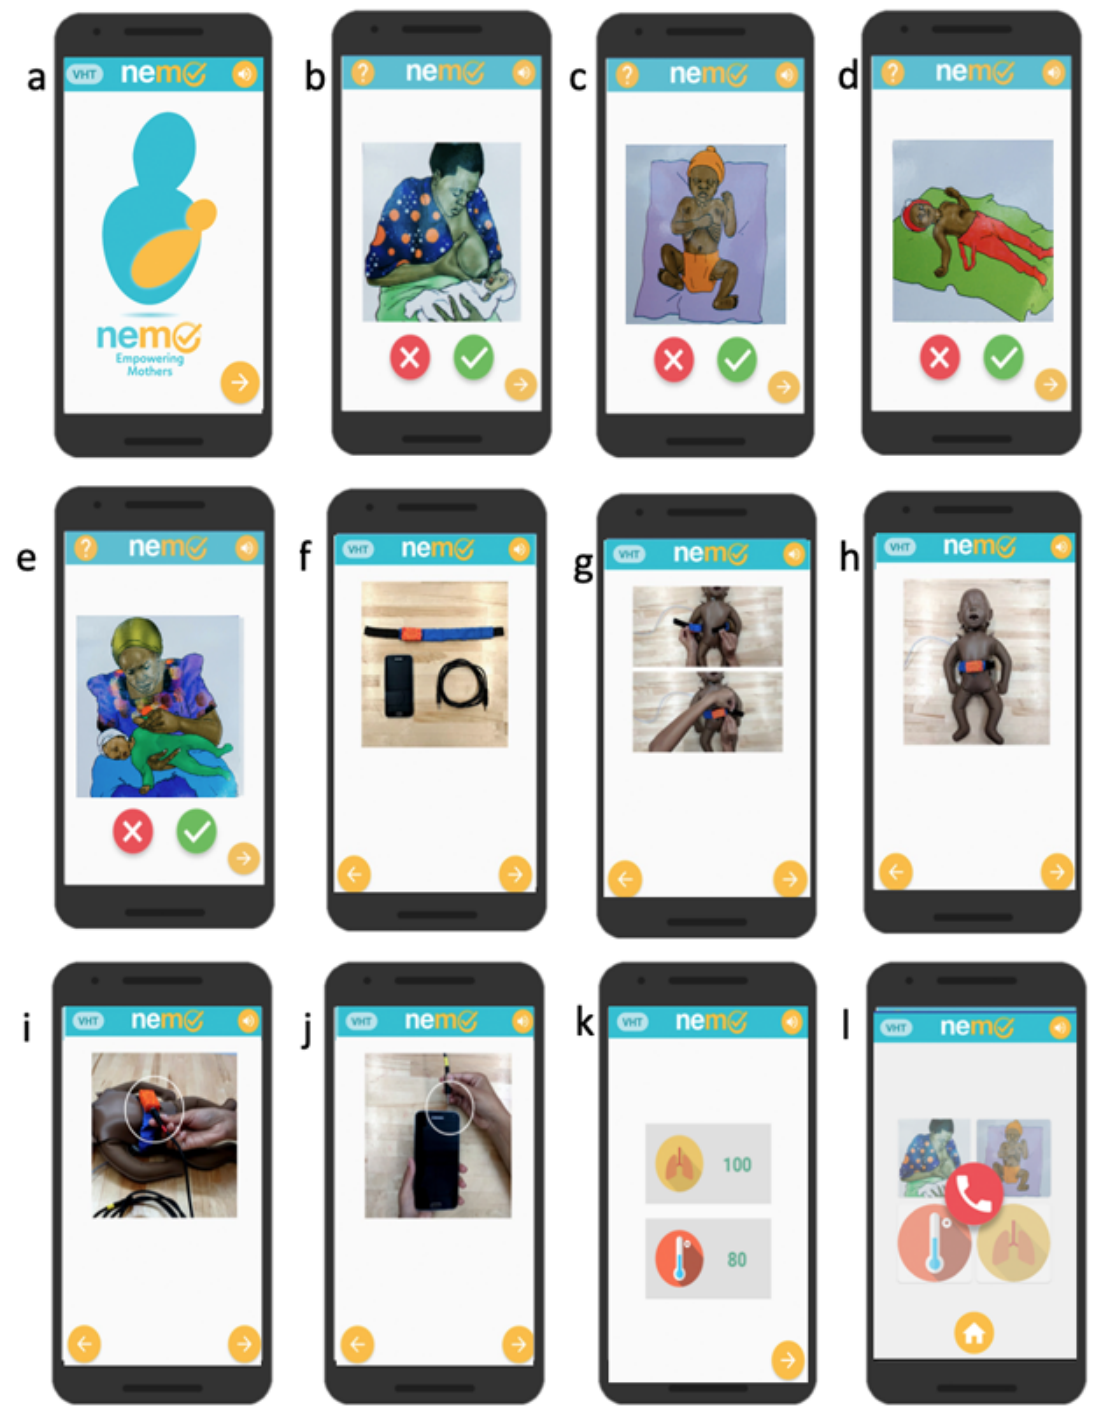
Figure 2. Illustration of the NeMo app, with qualitative danger sign assessment screens: a) home screen; b) difficulty breastfeeding; c) chest indrawing; d) convulsions; and e) lethargy. The mother can select the X or check symbols to respond as to whether her child is sick or healthy. Instructions on how to place the band are shown in f-j. Respiratory rate and temperature are displayed in k). Danger signs detected, and need to call a CHW are shown in l. NeMo: Neonatal Monitoring; CHW: community health